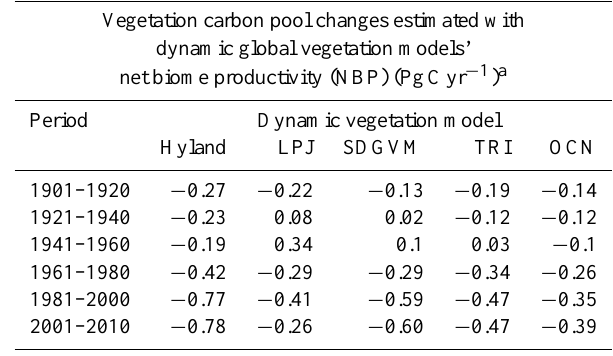
Table 11. Exports of wood and wood products. Vegetation carbon pool changes estimated